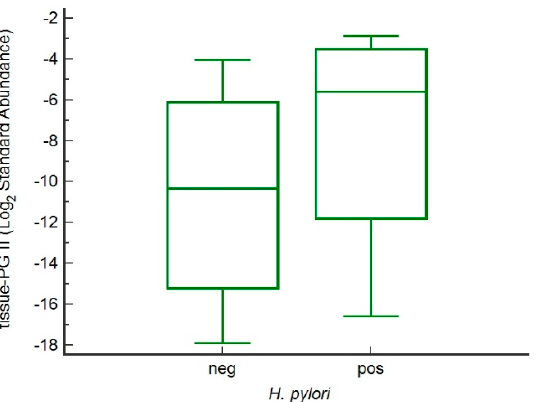
Figure 5. Box plot showing median increased of PGII standard abundance in H. pylori -related GC tissue specimens.